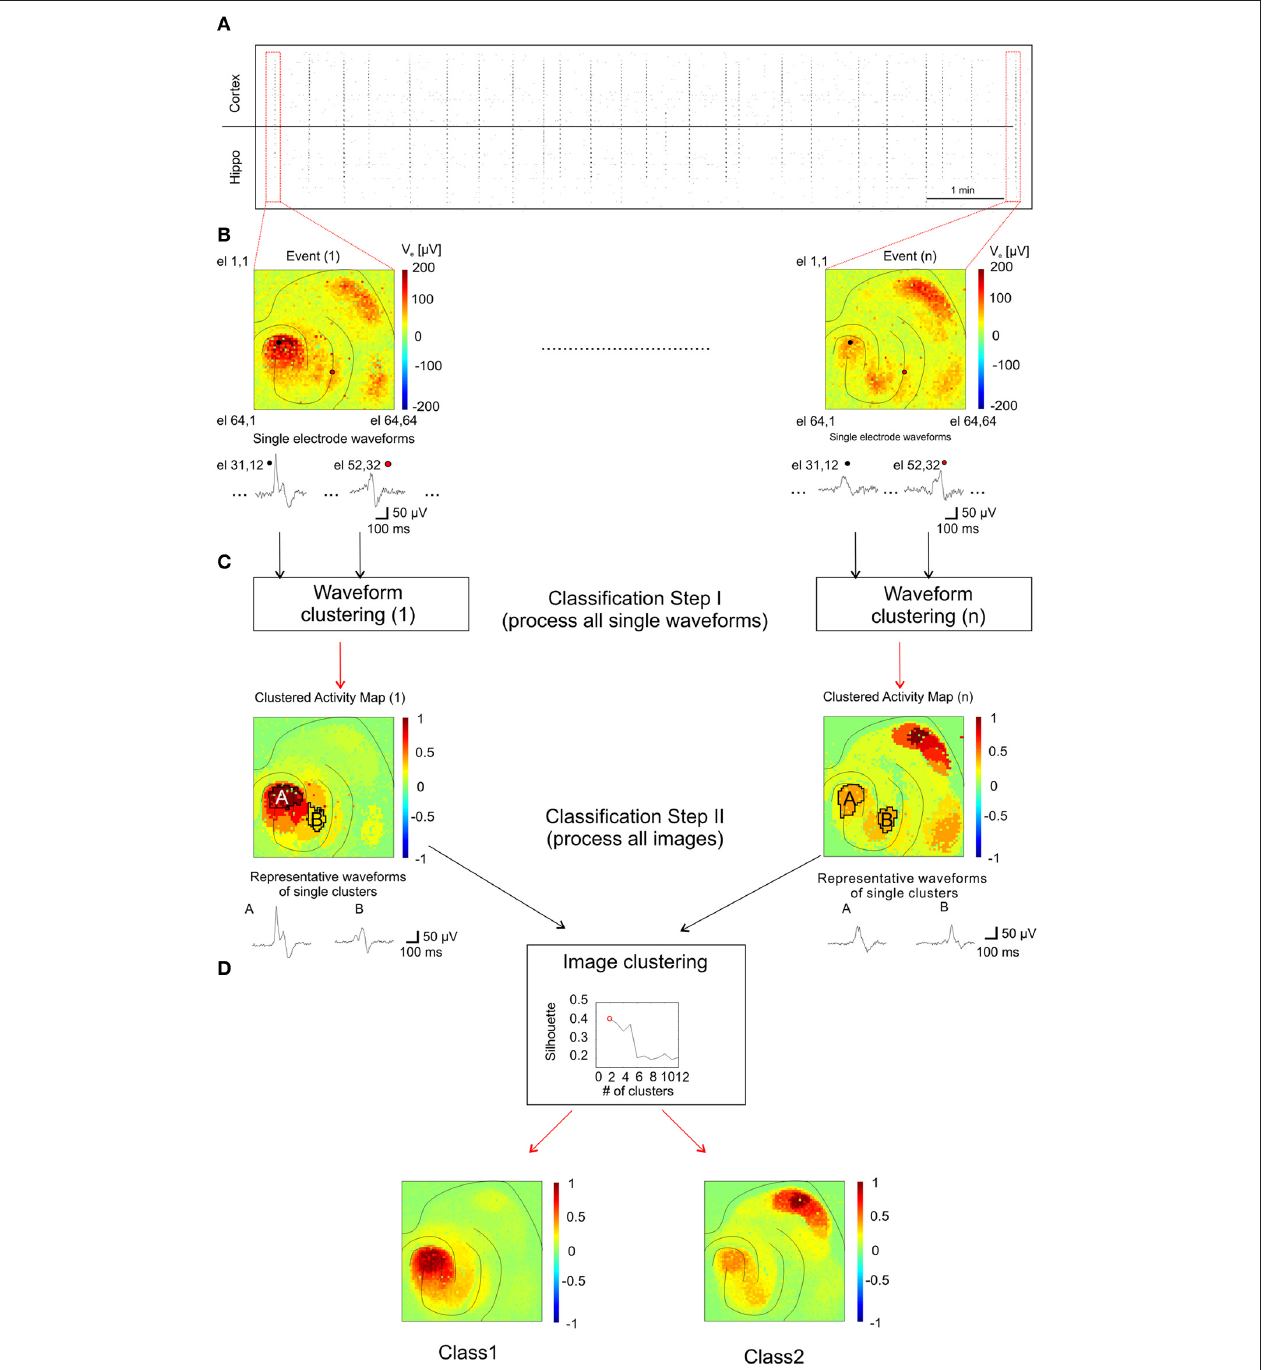
FIGURE 7 | Analysis method for classification of I-IC patterns. (A) Raster plot showing the time course of 20min of recording with dots indicating each detected I-IC for each active electrode. Columns of points therefore indicate single I-IC events recorded in all the active area of the chip. (B) Color-map code showing the maximum amplitudes recorded for two different events. The traces are representative of two pixels highlighted with a black and a red circle, respectively. All the electrodes for all the I-IC events were classified with the kmeans algorithm. (C) Results of the previous classification are shown as spatial map of activation which